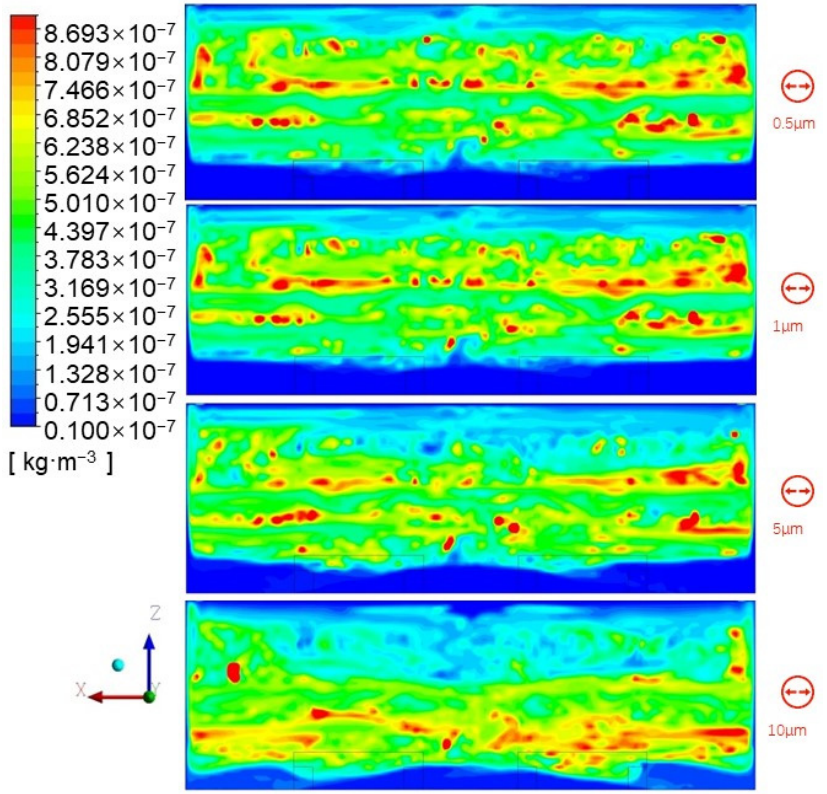
Figure 8. Concentration distribution of particles with various sizes in XZ plane at Y = 7.5 m under ACR = 3.